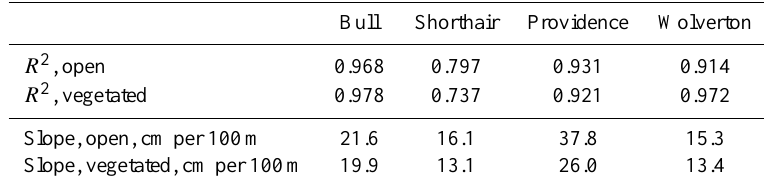
Bull Shorthair Providence Wolverton